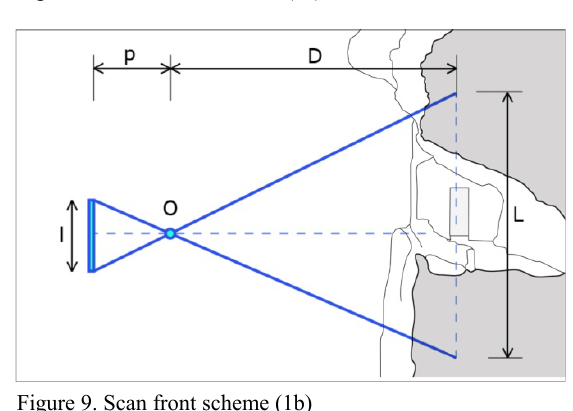
Figure 8. Scan zenith scheme (1a)